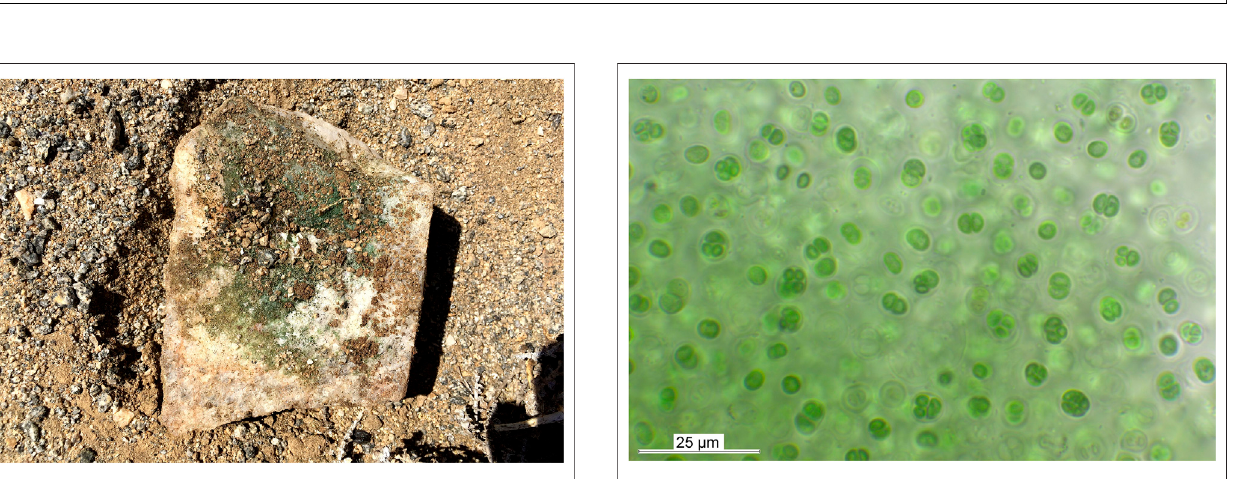
FIGURE 7 | Hypothetic location of phototrophic microorganisms in Martian caves. Modi fi ed from image of Melissa Ausburn.